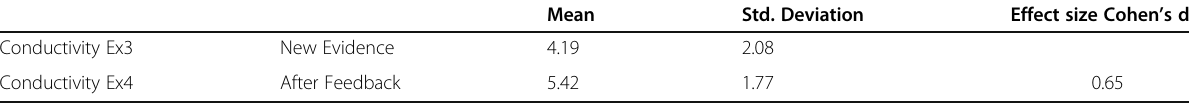
Table 6 Student Conductivity science ideas across an evolving explanation ( n = 54*)